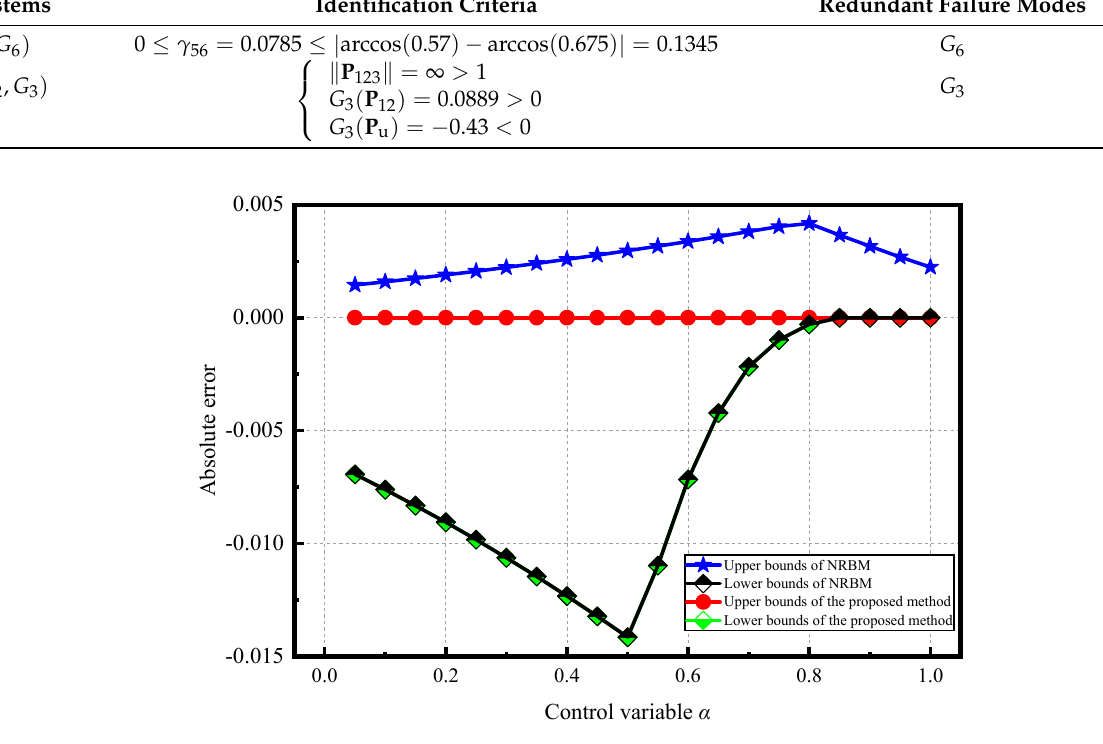
Figure 6. Absolute errors under the variation of the control variable α for numerical example